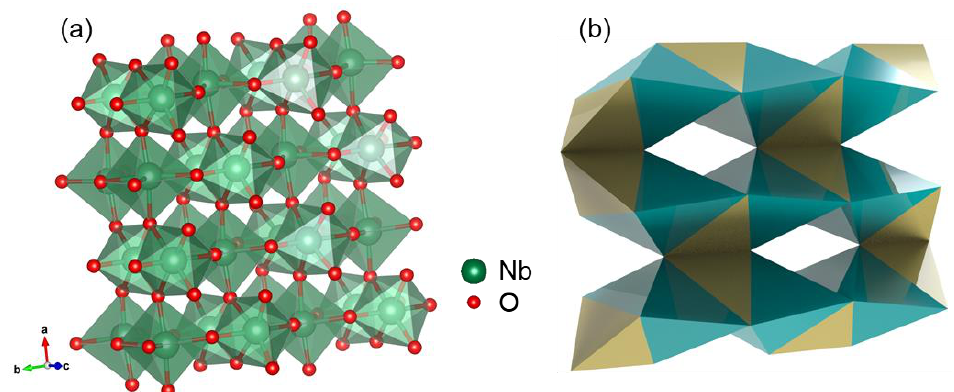
Figure 1. ( a ) Crystal structure of NbO 2 at room temperature and ( b ) expanded view of some octahedral and tetrahedral sites between the octahedra seen in ( a